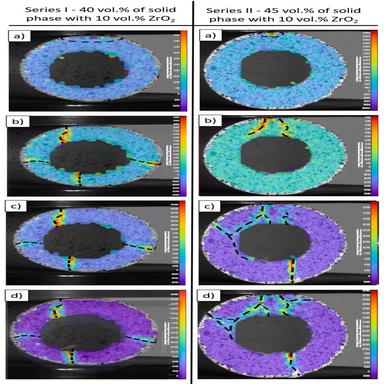
Sample maps of deformations for centrifugal slip-cast composites; the maps were prepared as a result of a strength test carried out on Instron 8802 MT hydraulic pulser: a) stage one, b) stage two, c) stage three, d) stage four.